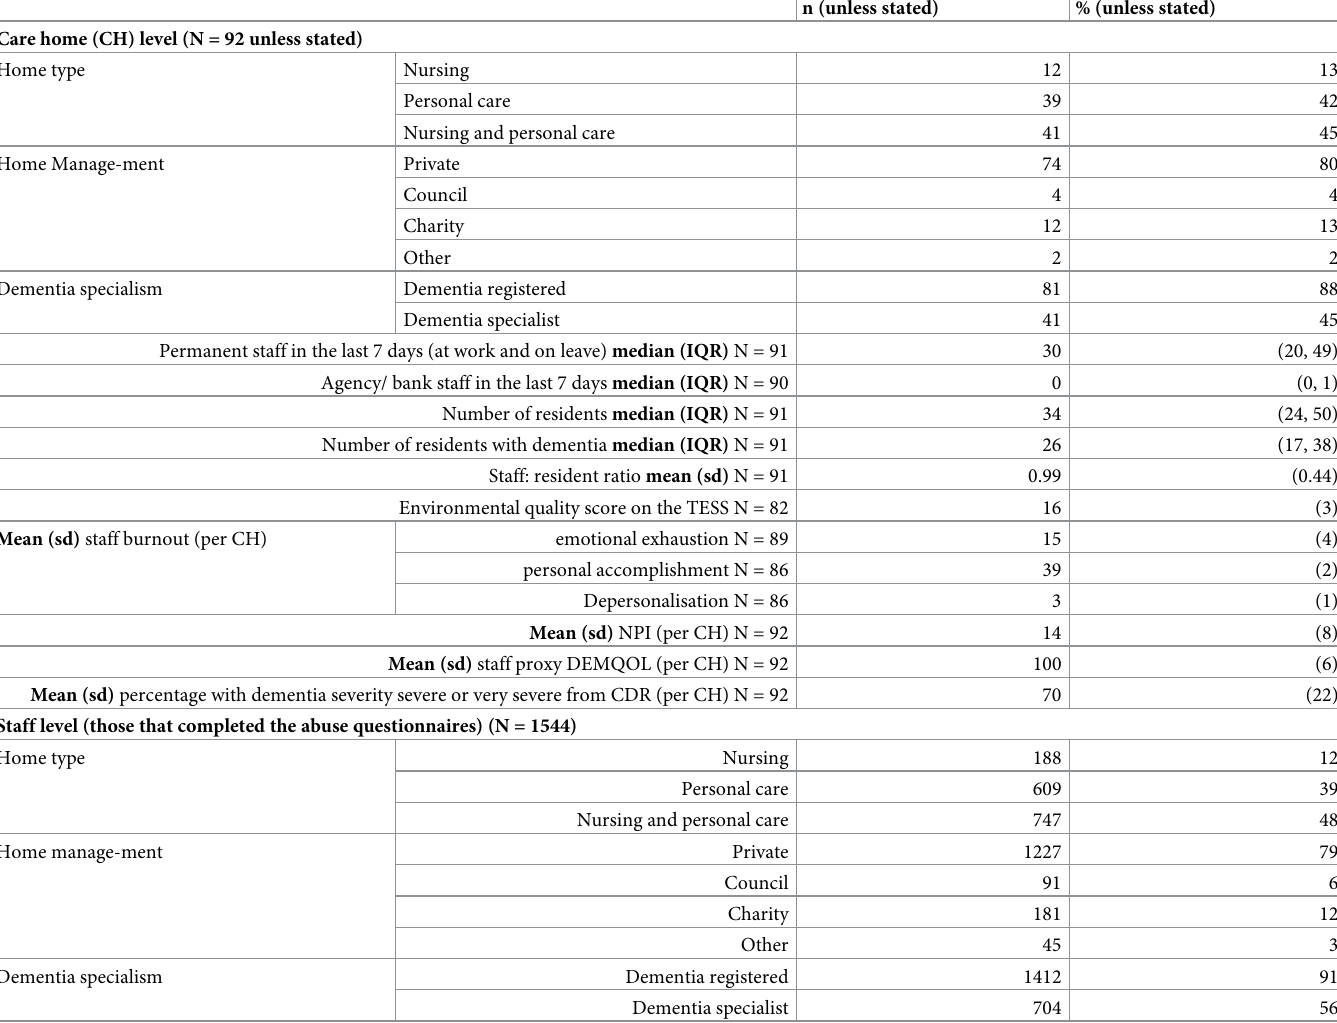
Table 1. Characteristics of care home